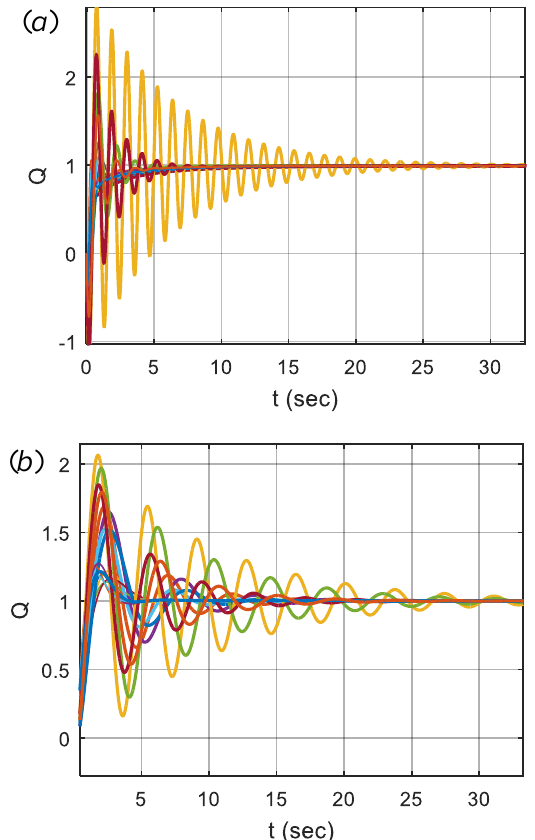
Figure 8. Step responses of 16 vertex plant functions; (a) FOPID controller and (b) PI controller. Table 2 lists the mean squared error (MSE) performance of these plants for step re- sponse (MSE performance for step response is calculated by Table 1. 16 plant functions that form vertices of the interval uncertainty box.